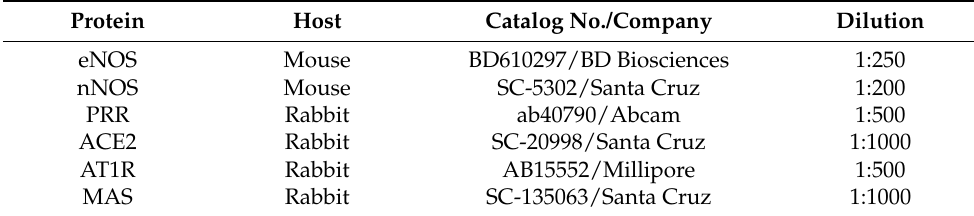
Table 1. Primary antibodies used for Western blotting. Protein Host Catalog No./Company Dilution eNOS Mouse BD610297/BD Biosciences 1:250 nNOS Mouse SC-5302/Santa Cruz Rabbit